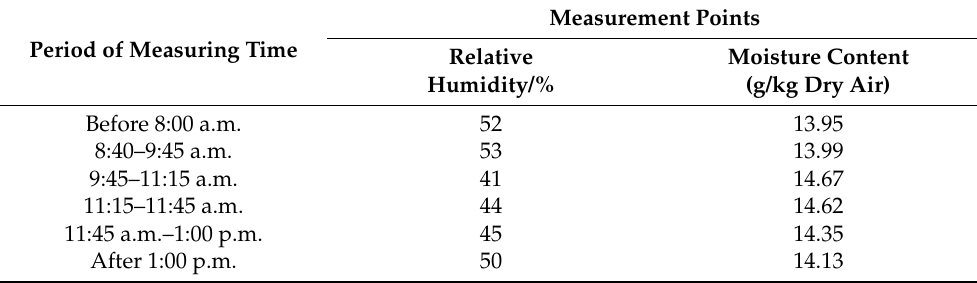
Table 3. Measured results of moisture contents at different periods.